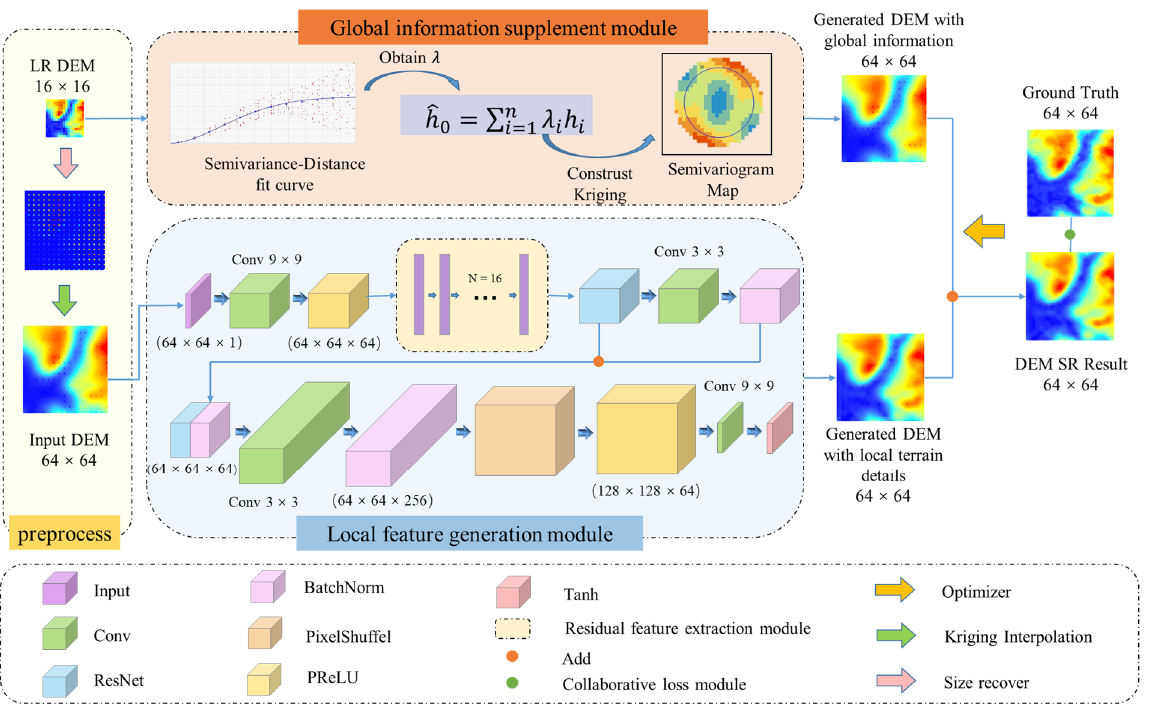
Figure 2. Overview of the proposed global-information-constrained deep learning network for generating super-resolution DEMs (GISR).